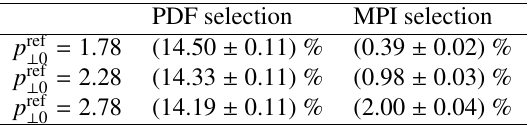
Table 2. Di ff ractive fractions for the 2 → 2 QCD processes with p ⊥ > 20 GeV in P ythia is run with the Schuler-Sjöstrand flux and the H1 Fit B LO